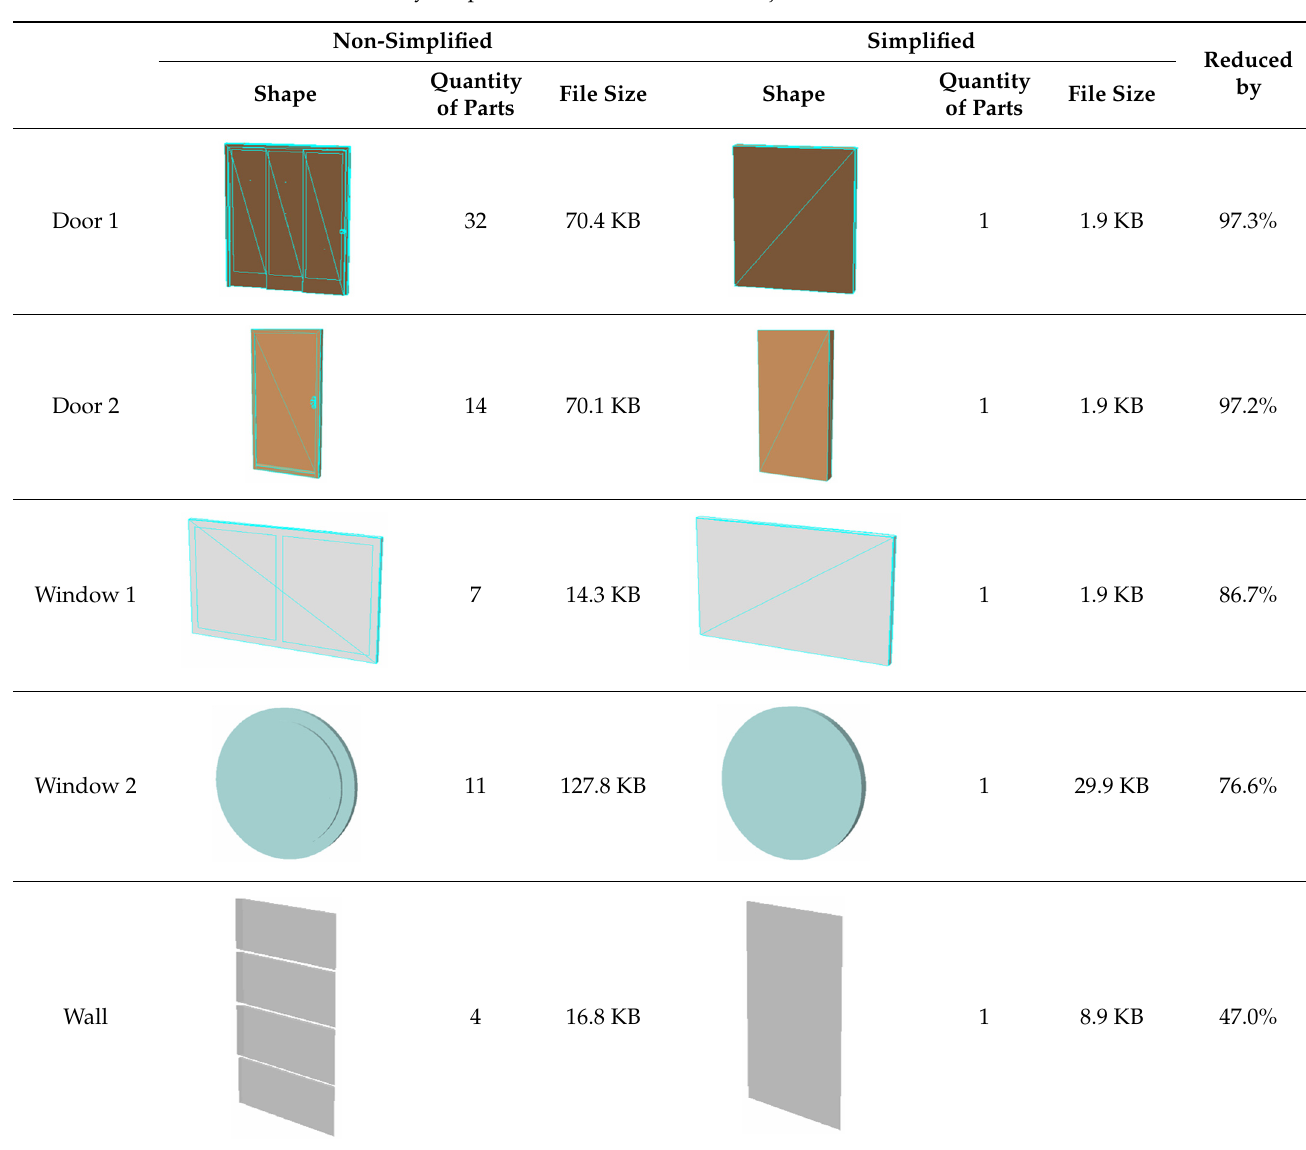
Table 8. Geometry simplification for over-detailed objects doors, windows, and walls.